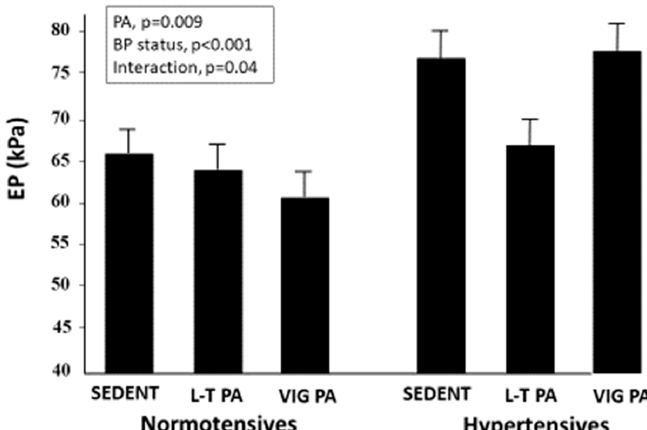
Figure 1. Pressure-strain elastic modulus (EP) in the study participants stratified according to physical activity level and blood pressure status. Sedent indicates sedentary subjects; L-T PA indicates leisure-time physical activity; VIG PA indicates vigorous physical activity (competitive athletes).